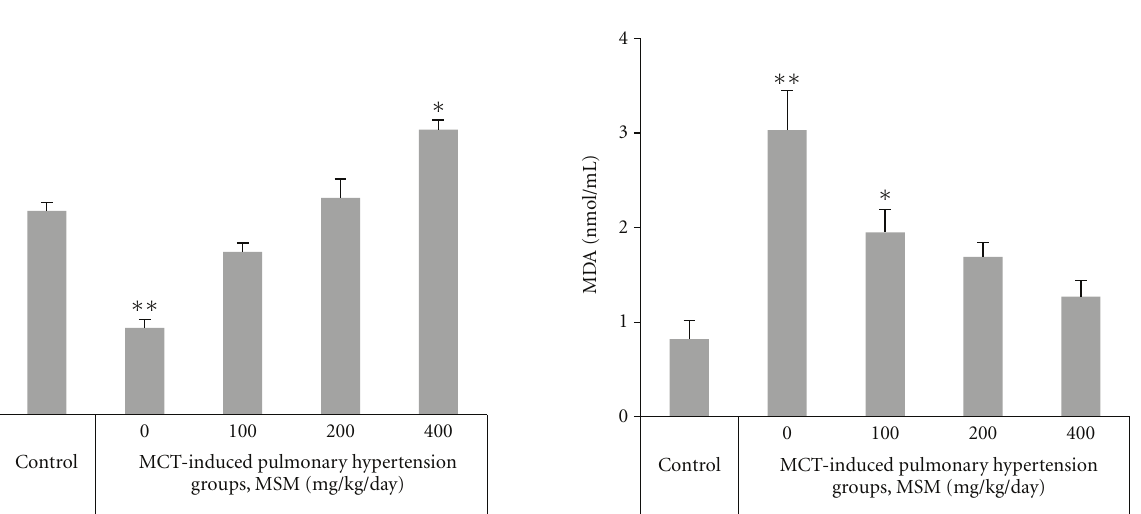
Table 3. MSM administration at 100 mg/kg/day significantly